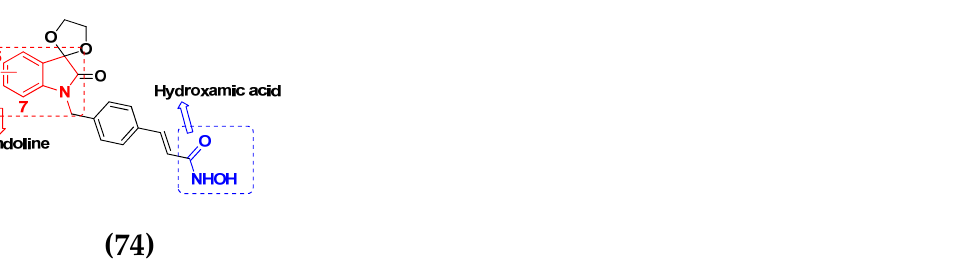
Figure 71. Structure of hydroxamic acid based indoline derivatives ( 74 ). Table 59. In vitro cytotoxic activities of hydroxamic acid based indoline hybrid compounds 74 ( a – d ).